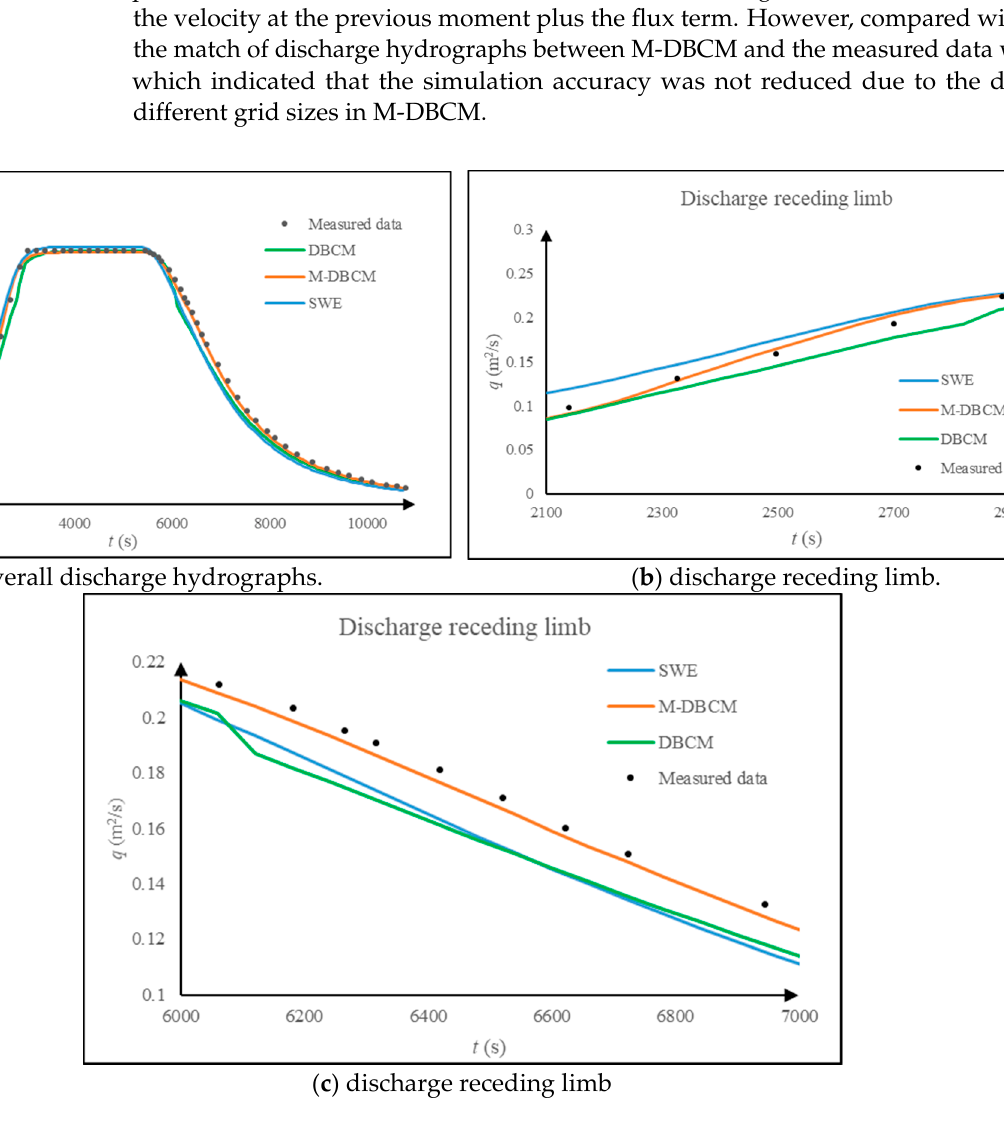
Figure 13. The hydrographs obtained from different models.